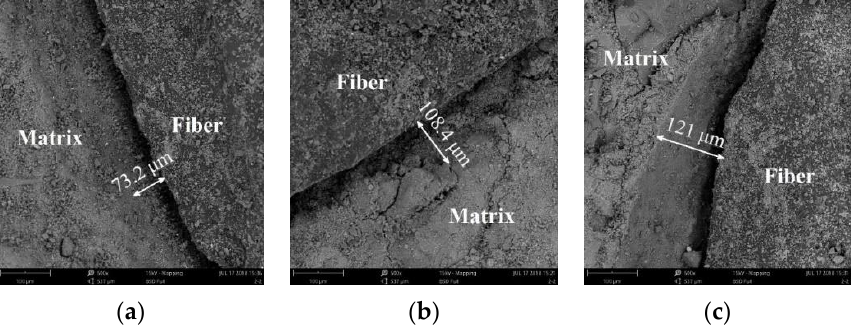
Figure 13. Annular crack width of specimens (water–cement ratio 0.55); ( a ) Tex content 9.2 k; ( b ) Tex content 18.4 k; and ( c ) Tex content 27.6